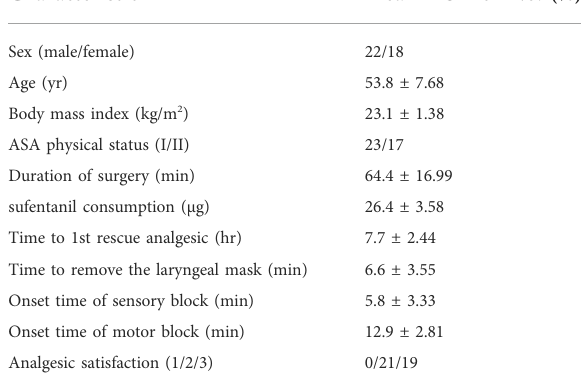
TABLE 1 Patient